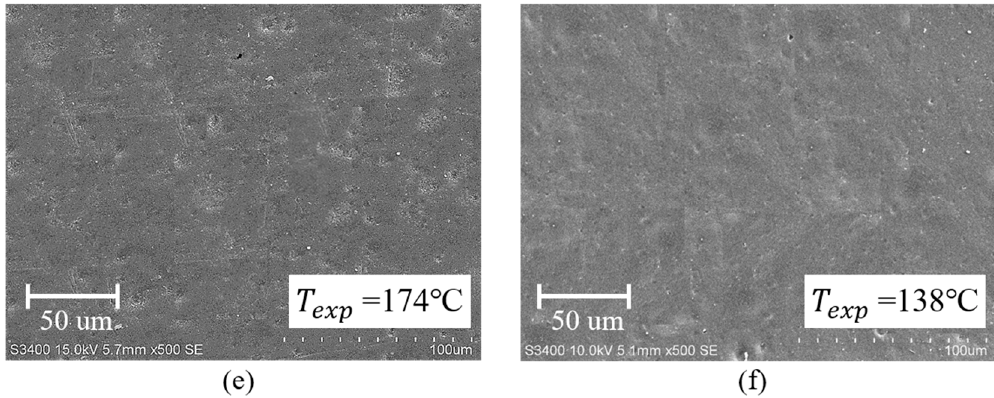
Figure 8. SEM images of ( a ) the as-received CFRP substrate surface and plasma-treated CFRP substrate surfaces of ( b ) P 5-10 , ( c ) P 5-14 , ( d ) P 10-14 , ( e ) P 5-18 , and ( f ) P 10-18 .